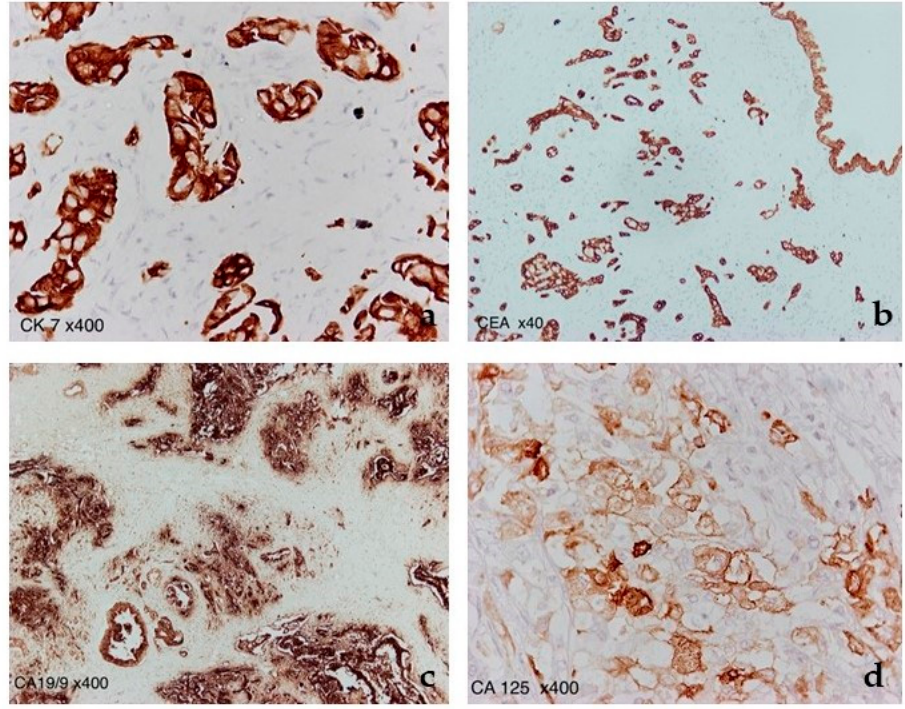
Figure 7. Immunostaining for ( a ) CK7 (400 × magnification), ( b ) CEA (40 × magnification), ( c ) CA19-9 (400 × magnification), and ( d ) CA125 (400 × magnification), highlighting the neoplastic glands of both adenocarcinomas.